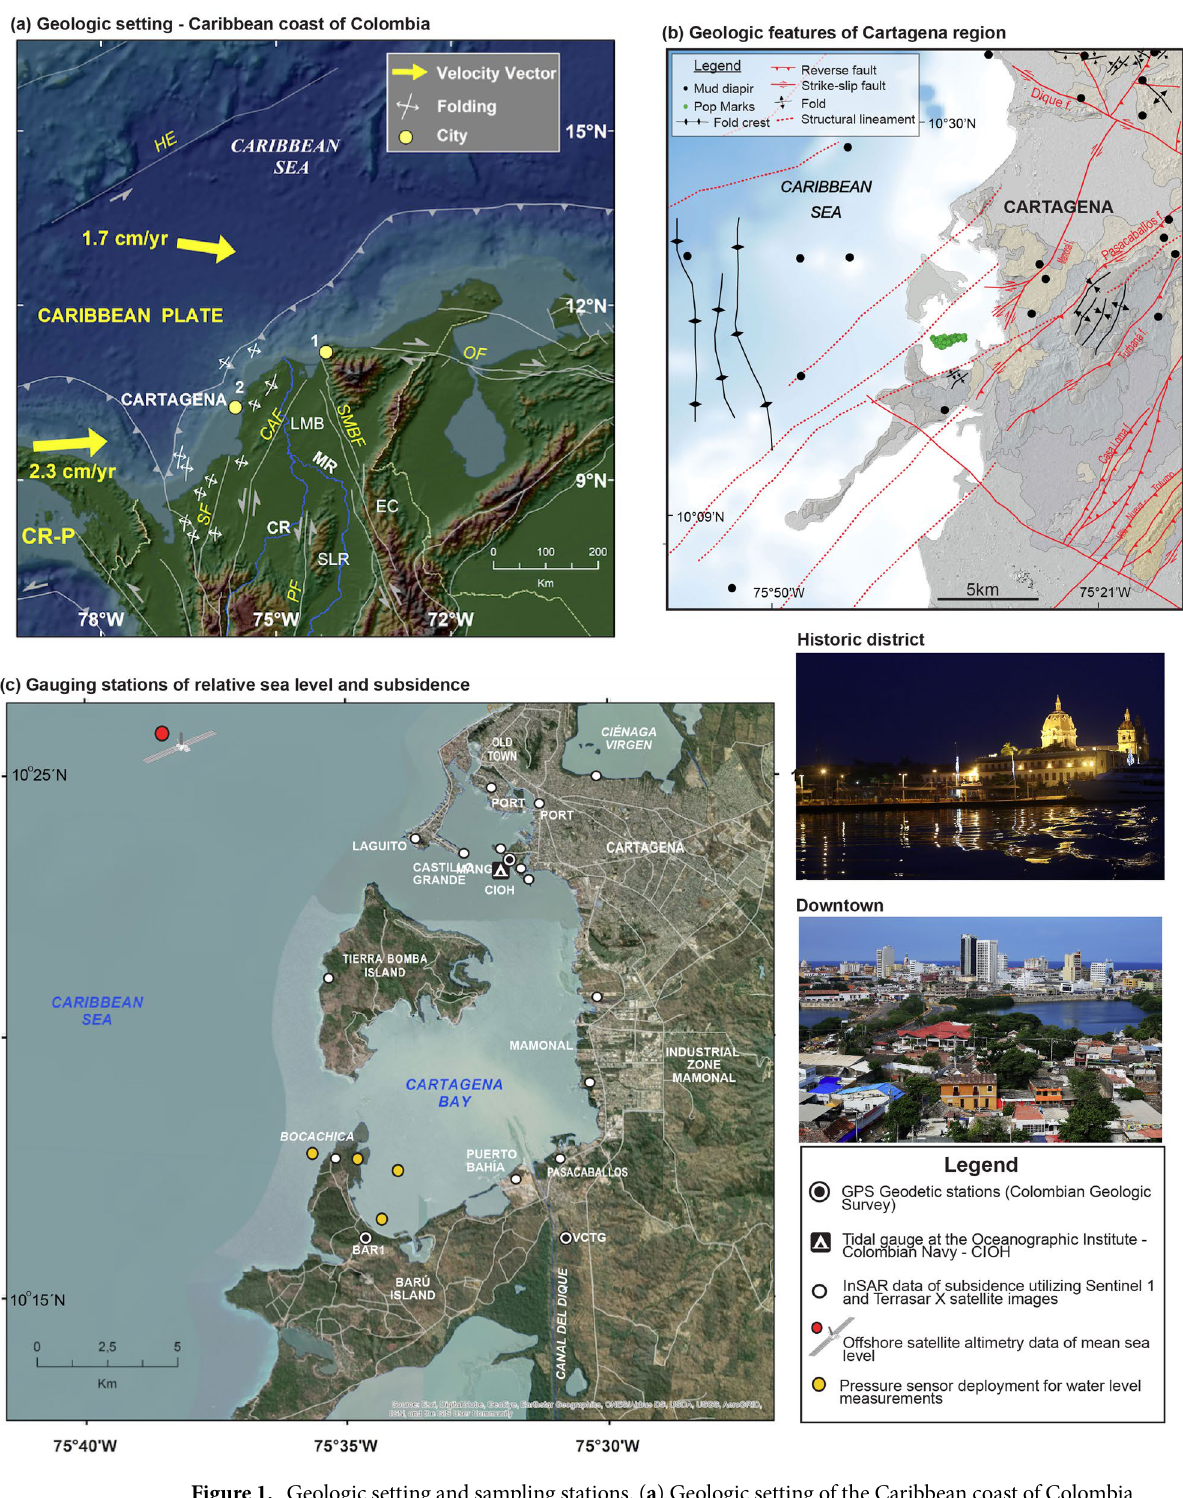
Figure 1. Geologic setting and sampling stations. ( a ) Geologic setting of the Caribbean coast of Colombia showing major tectonic plates and faults, mountain ranges, rivers, and coastal cities (CR-P: Costa Rica Panamá Microplate; Cr: Cocos Ridge; CR: Cauca River; MR: Magdalena River; SLR: San Lucas Range; EC: Eastern Cordillera; SF: San Jeronimo Fault; PF: Palestina Fault; SMBF: Santa Marta Bucaramanga Fault; OF: Oca Fault; Cities: 1. Santa Marta; 2. Cartagena; 3. Panama City). GPS velocities relative to South America plate. ( b ) Main geologic features that produce tectonic-induced vertical motions in Cartagena region, including mud volcanoes and diapirs (see Supplementary Fig. S2), associated pop marks, and tectonic faults. ( c ) Map of Cartagena city and its bay, showing the main gauging stations of relative seal level and land subsidence used in this study. ( a – c ) maps generated by ArcMap from ESRI, https:// deskt op. arcgis. com/ es/ arcmap/ ( Photo credits of Cartagena – Juan D. Restrepo, IDRC-BASIC